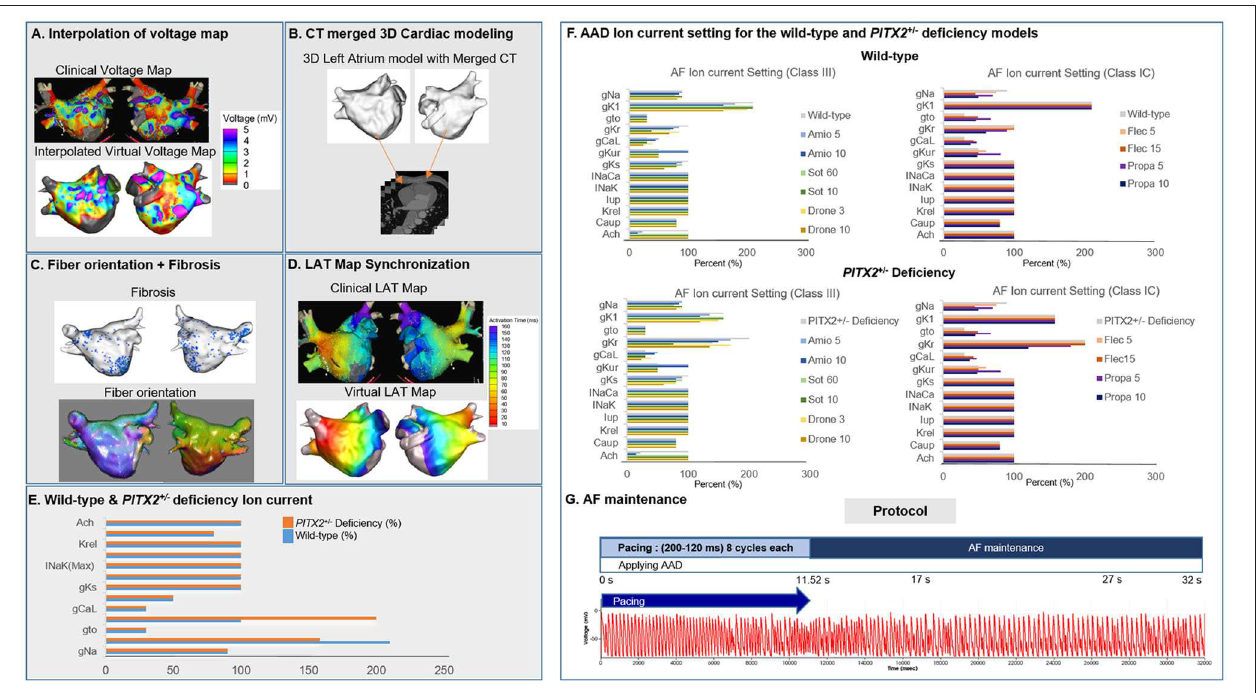
FIGURE 1 | Study method for the 3D left atrial modeling. The voltage map (A) , CT images (B) , fiber orientation (C) , fibrosis (C) , and LAT synchronization (D) were used for the LA modeling. The wild-type and PITX2 + / − deficiency ion currents (E,F) was implemented to simulate for wave dynamics analysis. AF pacing protocol (G) was conducted to analyze the AF initiation and